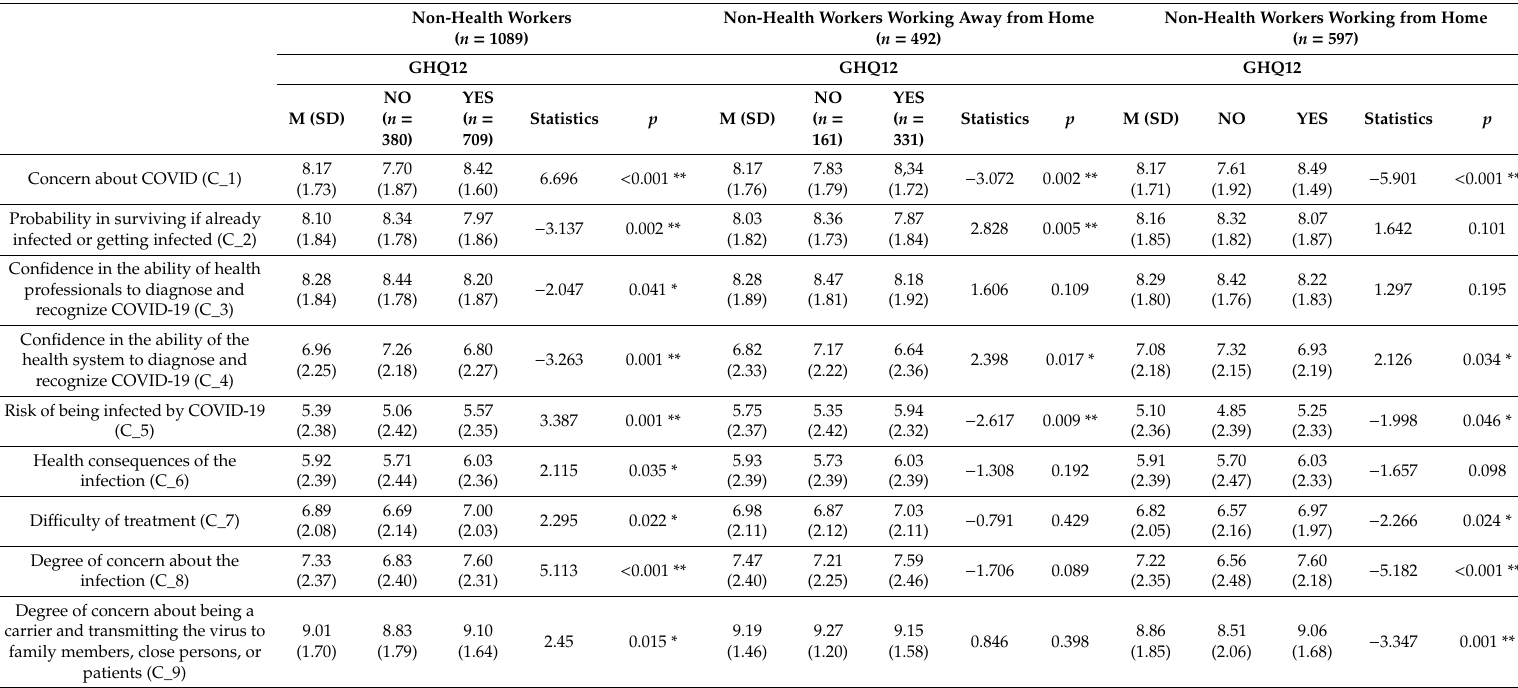
Table 1. Relationship between variables related to beliefs about the outbreak and psychological distress among non-health workers working during the pandemic. Non-Health Workers Non-Health Workers Working Away from Home Non-Health Workers Working from Home ( n = 1089) ( n = 492) ( n = 597) GHQ12 GHQ12 GHQ12 Statistics Statistics